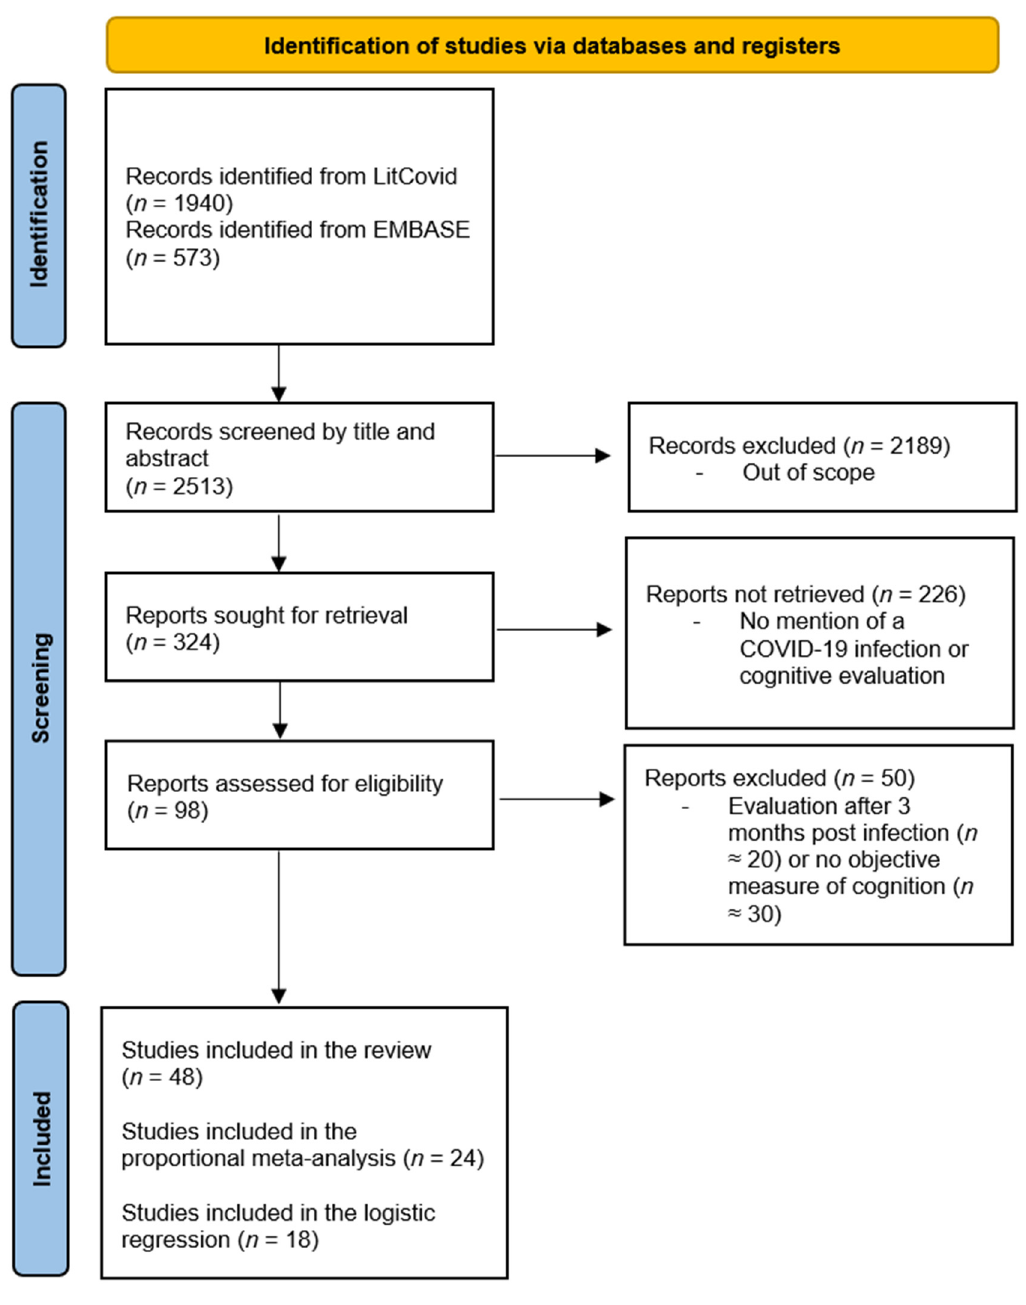
PRISMA flowchart of the article selection process over the two search periods. PRISMA = preferred reporting items for systematic reviews and meta-analyses.